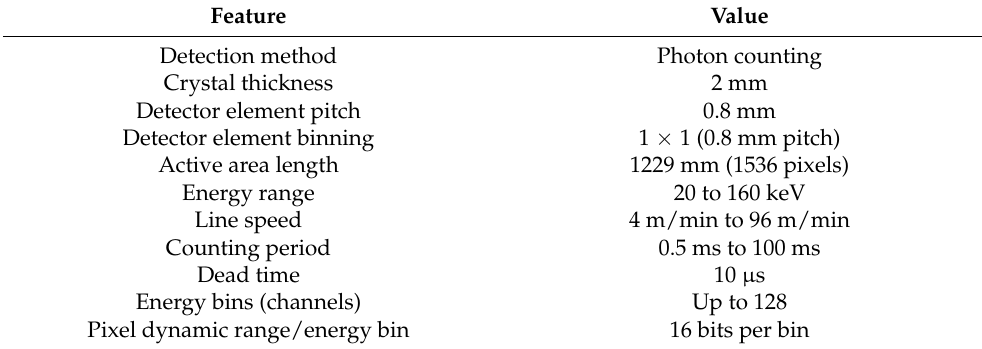
Table 1. The detector